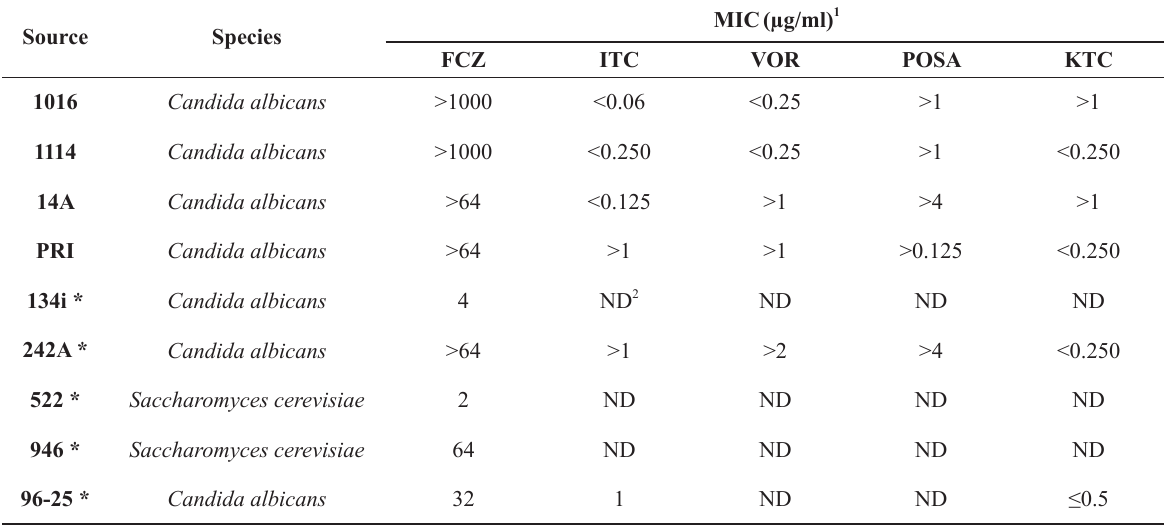
Evaluation of the Minimum Inhibitory Concentration (MIC) of azoles against C. albicans and S. cerevisiae